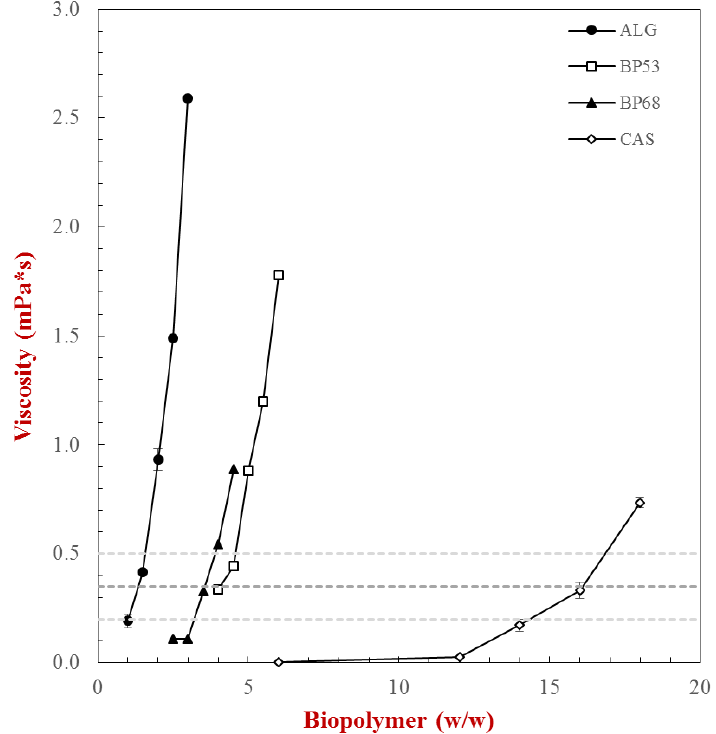
Figure 3. Impact of biopolymer concentration on the solution viscosity (measured at a shear rate = 100 s − 1 ): caseinate (CAS), alginate (ALG), sugar beet pectin DE 53% (BP53), and sugar beet pectin DE 68% (BP68). The measurements were conducted at 25 ◦